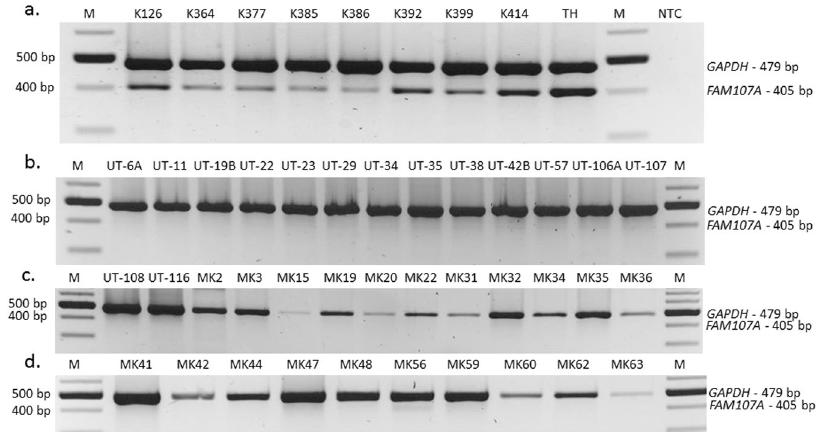
Figure 2. Retained expression of FAM107A in non-tumor controls (K samples; panel a) and lack of FAM107A expression in laryngeal cancer samples: cell lines (UT samples; panel b and c) and primary tumors (MK samples; panel c and d). GAPDH expression was used as the internal control. NTC – no template control. Size marker Perfect TM 100–1000 bp DNA Ladder